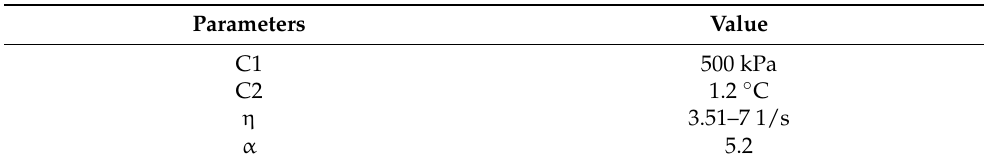
Figure 2. Variation of axial strain rate with the stress deviator. Orange and blue points represent experimental results from [29] at different temperatures, red dotted and light blue point dotted lines represent the fitting of the proposed approach: finally, the black line represents the commonly used approach. Table 1. Summary of imposed and calculated